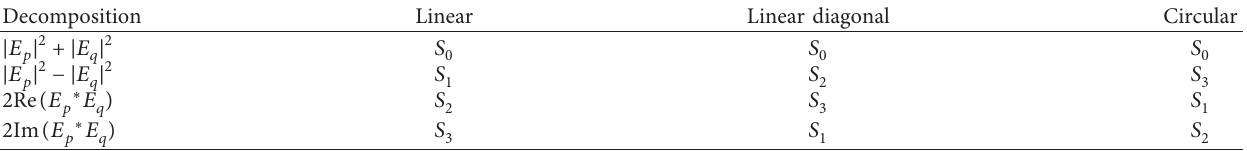
The subscripts “p” and “q” in linear basis represent “x” and “y”; in diagonal basis, they represent “+45 ° ” and “ − 45 ° ”; in circular basis, they represent “R” and “L,”